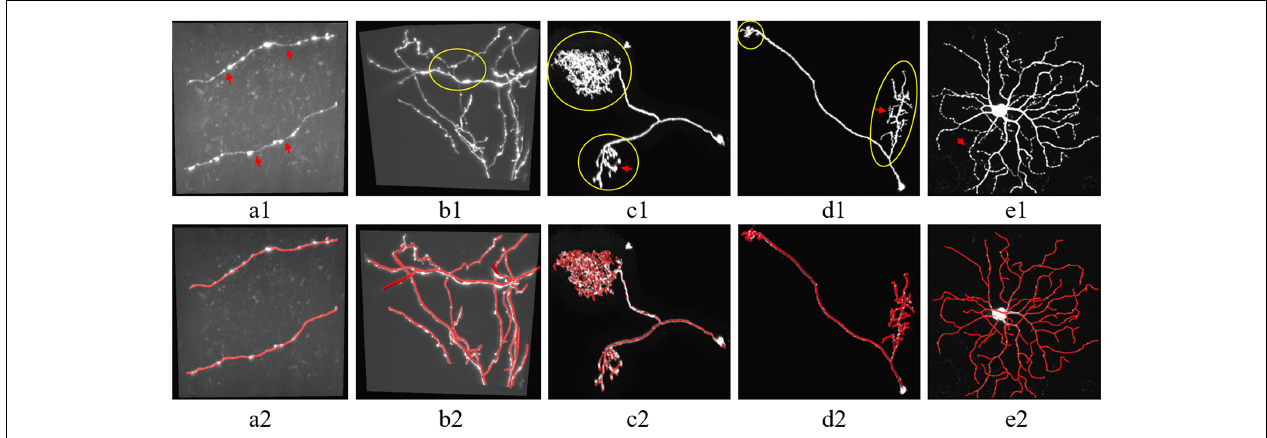
FIGURE 1 | Examples of 3D optical neuronal images with complex tree-like distorted structures and broken parts of the neurite. (A1,B1) Images from fluorescence micro-optical sectioning tomography (fMOST) datasets. (C1–E1) Images from BigNeuron datasets. (A2–E2) Corresponding manual tracing results of (A1–E1) . Yellow circles point out some twisted structures with various directions. Red arrows point to some broken neurite parts with the sudden change of intensity.